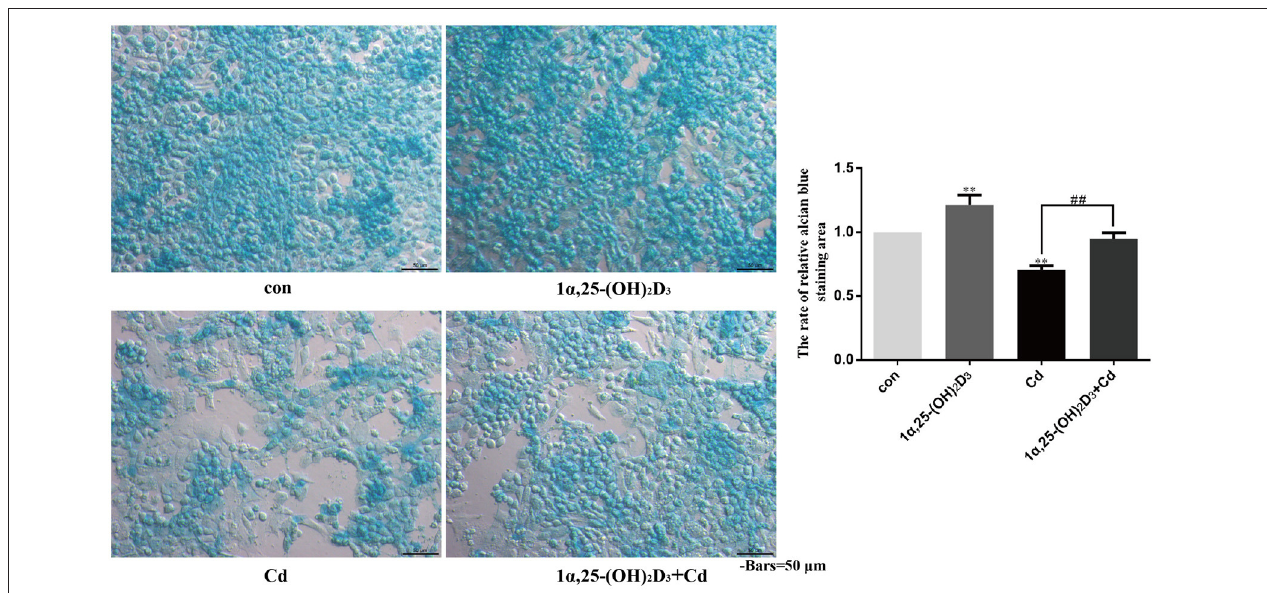
FIGURE 7 | 1 α ,25-(OH) 2 D 3 alleviated the inhibitory effect of Cd on the expression of acid mucopolysaccharide in chondrocytes. Alcian blue staining was used to detect the acid mucopolysaccharide in chondrocytes pretreated with 10 − 8 M 1 α ,25-(OH) 2 D 3 for 1 day followed by 3 days of combined treatment with 2 µ M Cd. Compared with the control group, 1 α ,25-(OH) 2 D 3 treatment alone increased the proportion of the alcian blue-stained area to the total cell area and Cd treatment alone reduced the proportion of the alcian blue-stained area to the total cell area. Compared with Cd treatment alone, the 1 α ,25-(OH) 2 D 3 and Cd combination treatment increased the proportion of the alcian blue-stained area to the total cell area. All data are represented as mean ± standard deviation; n = 3; * P < 0.05 and ** P < 0.01, significant difference relative to the day 0 group; # P < 0.05 and ## P < 0.01, significant difference between the combination treatment group and Cd monotherapy